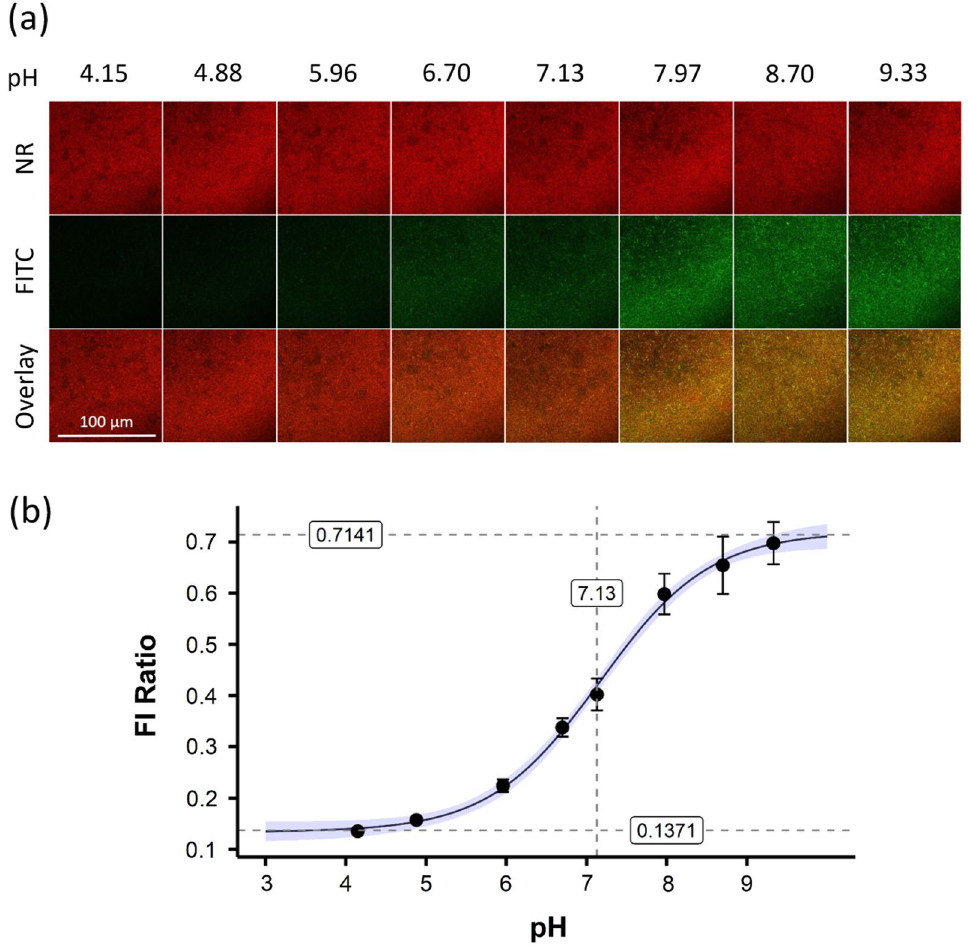
Figure 3. Fluorescence imaging of the nanosensor in reference buffers with CLSM. ( a ) The nanosensors FITC (green) and NR (red) fluorescence were imaged in 8 different reference buffers. For each pH value the entire depth of the biofilm was imaged as a Z-stack. A representative 2D image plus an overlay are shown for better visualization. The 100 µm scale bar applies to all images. ( b ) The FI ratio of the FITC to the NR signal was plotted against the respective pH. The blue area represents the confidence interval of the curve fit, and the error bars indicate the standard deviation. The experiments were performed as 3 independent